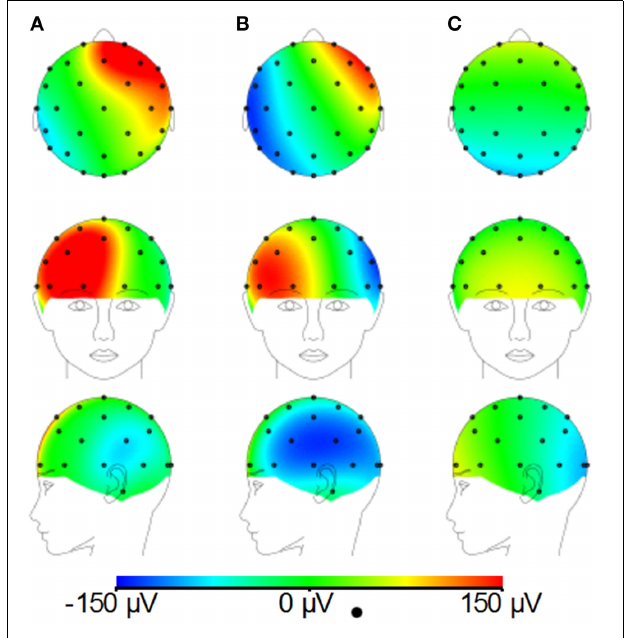
FIGURE 3 | Variation of the range (A) and RMS (B) of the average GA (over electrodes) with cable bundle position (along the midline) for simulated RL, AP, and FH gradients. The dashed lines indicate the cable bundle position on standard (black) and optimally modified (red) caps.